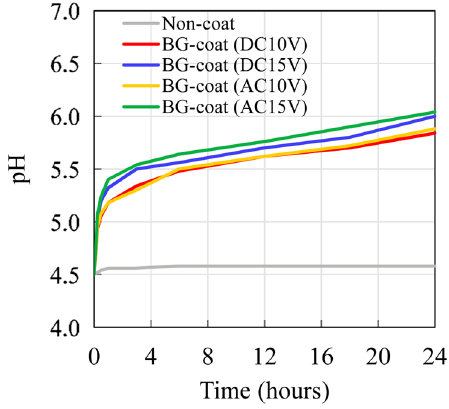
Figure 6. Time ‐ dependent changes in the pH of the solutions as an indication of acid neutralizing ability.